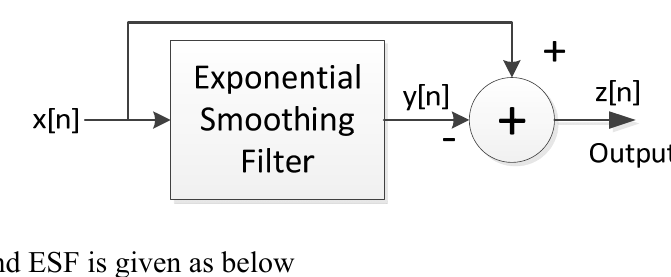
Figure A1. Filter